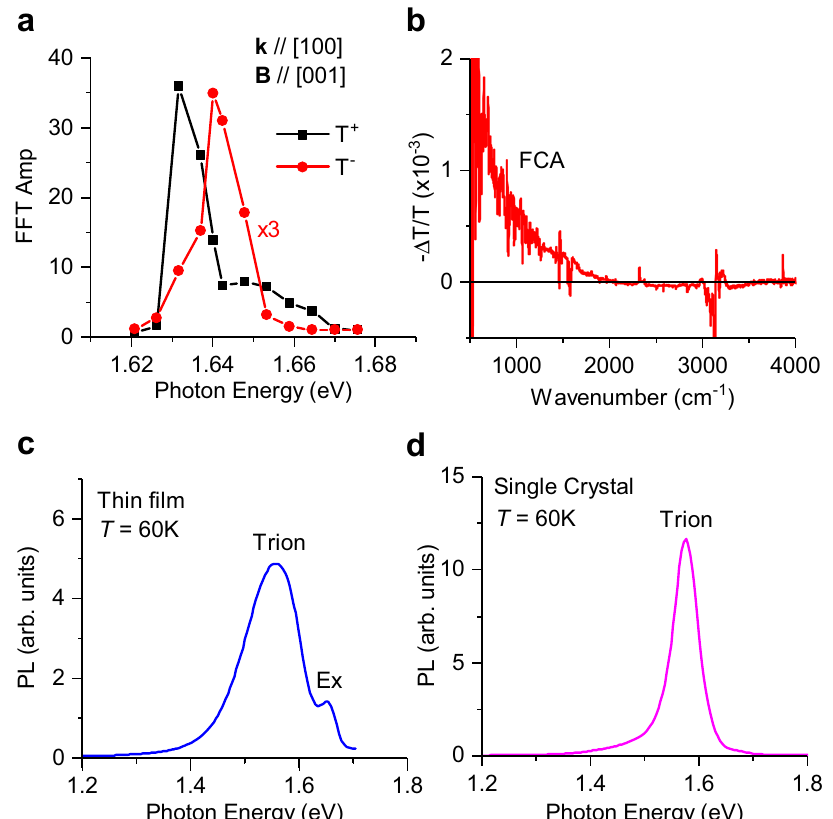
Fig. 6 The quantum-beating excitation spectra, photoinduced free carrier-absorption spectrum, and photoluminescence spectra. a The quantum- beating FFT-amplitude spectra of the fast (T + ) and slow (T − ) oscillations, referred to as QB-excitation spectra, measured at B = 400 mT on (100) facet with applied B fi eld along [001]. The QB-excitation spectra peak at 1.63 eV for the fast oscillations and 1.64 eV for the slow oscillations, both energies are below the exciton optical transition at 1.65 eV. b The photoinduced absorption (PA) spectrum of MAPbI 3 thin fi lm measured at 60 K using a FTIR spectrometer, excited at 470 nm, which shows free carrier-absorption (FCA) spectrum. c The PL-emission spectrum of a MAPbI 3 thin fi lm measured at 60 K that shows two bands: the higher-energy band ~1.65 eV is due to free exciton emission and the lower, broader band originates from trapped excitons in charged shallow traps (or trions). d The PL spectrum of a MAPbI 3 single crystal measured at 60 K, which is predominantly due to trions.